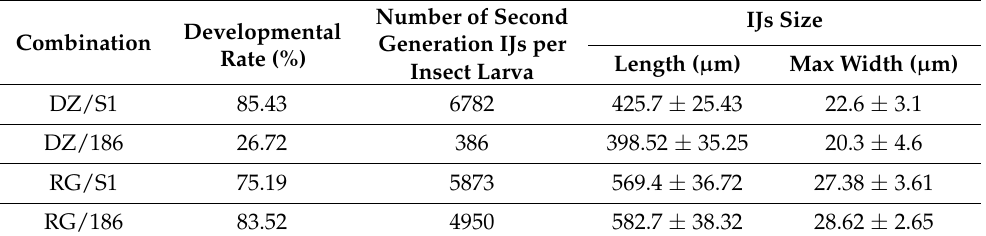
Figure 1. Symbiotic bacterial strains impact pathogenicity, longevity, stress resistance, and chemo- taxis of Osheius chongmingensis . ( A ) The four monoxenic nematode/bacterium combinations of O. chongmingensis and O. rugaoensis associated, respectively, with S. nematodiphila S1 (DZ/186 and DZ/S1) and S. nematodiphila DR186 (RG/186 and RG/S1). ( B , C ) Pathogenicity changes of IJs of DZ/S1 and DZ/186, respectively, after multigenerational passage through G. mellonella in vivo. ( D ) Percent change in bacterial carriage of IJs of the four combinations after multigenerational passage. ( E – H ) Effects of symbiotic bacterial strains S1 and 186 on longevity, stress tolerance, and chemotaxis to benzaldehyde of O. chongmingensis. ** p < 0.01; *** p < 0.001. Table 1. Effects of Serratia nematodiphila strains on development and reproduction of the first genera- tion IJs of Heterorhabditidoides in different